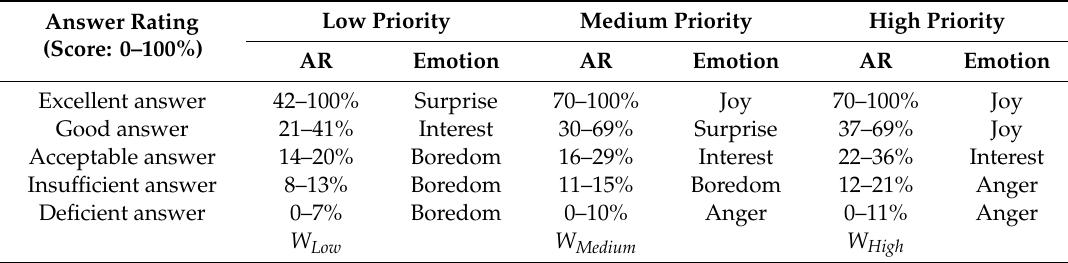
Table 10. Answer Rating (AR) calculations: reserved personality